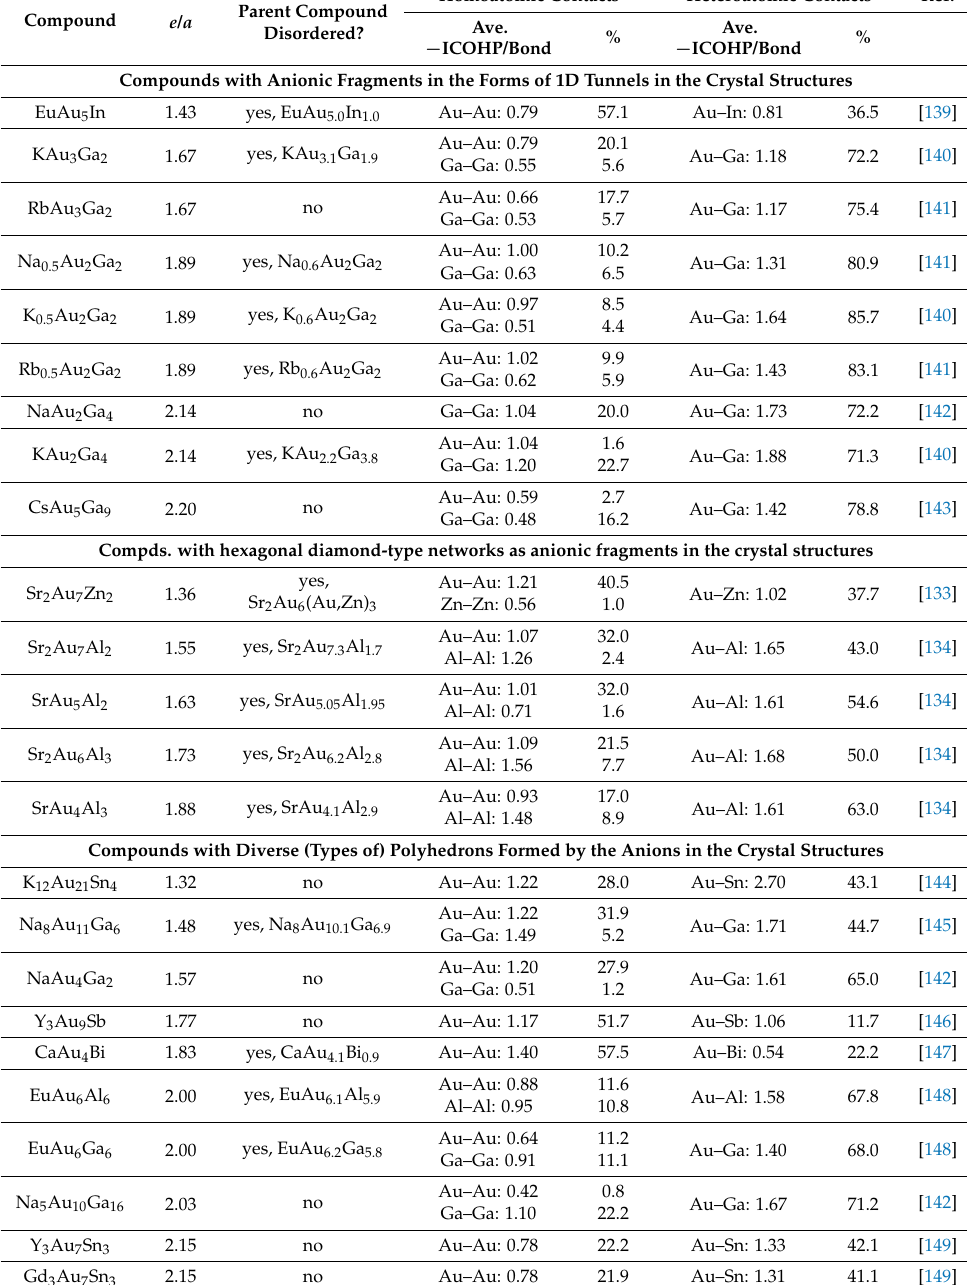
Table 4. e / a ratios a , average − ICOHP/bond values and respective percentages to the net bonding capabilities of the Au–Au and post-transition-metal–post-transition-metal as well as Au–post-transition-metal interactions for diverse active-metal-poor intermetallics composed of an active metal (group one–three element), gold and a post-transition-metal. Details about the quantum chemical computations and the crystal structures may be extracted from the respective